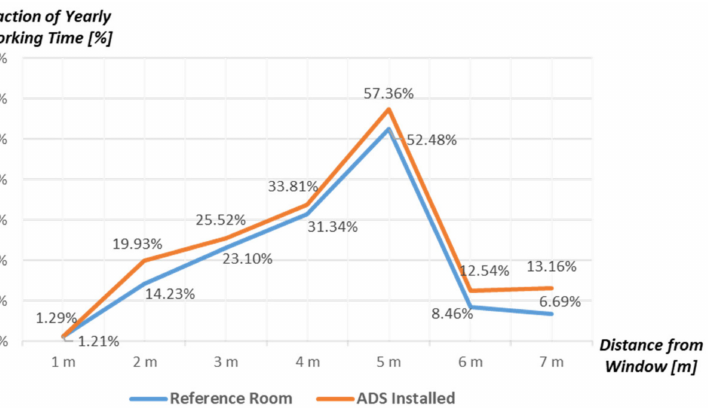
Figure 8. The effect of the ADS on annual disturbing glare (when DGP > 38%) based on a yearly fraction of